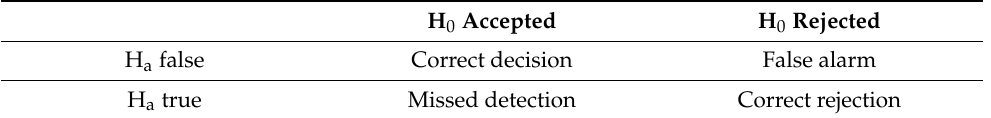
Table 1. Fault hypotheses and actions